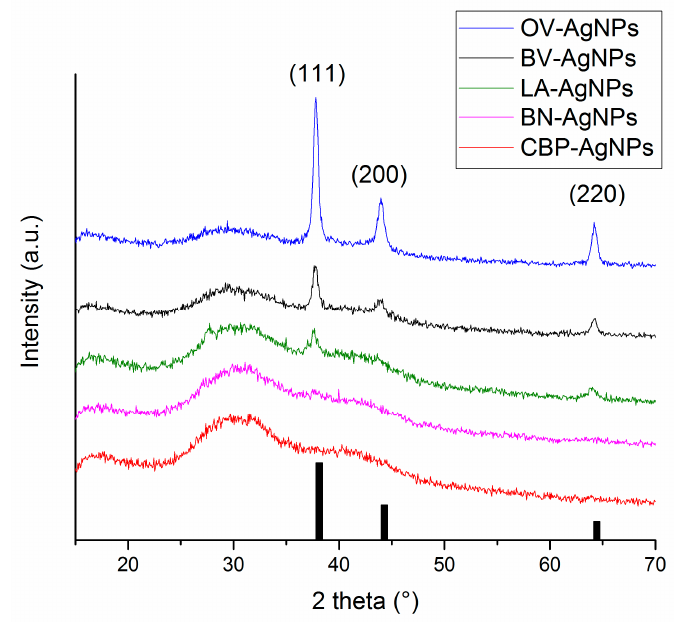
Figure 4. The X-ray diffraction (XRD) patterns of the dried solids after centrifugation after the green synthesis of AgNPs starting from 5 mM AgNO 3 and using 5 different plants. Bar graphs represent the Bragg‘s reflections of cubic base-centred (fcc) elemental silver (ICDD-PDF2-065-2871). The Miller indices of the crystallographic planes corresponding to the three most intensive reflections of fcc-Ag are indexed in parentheses.